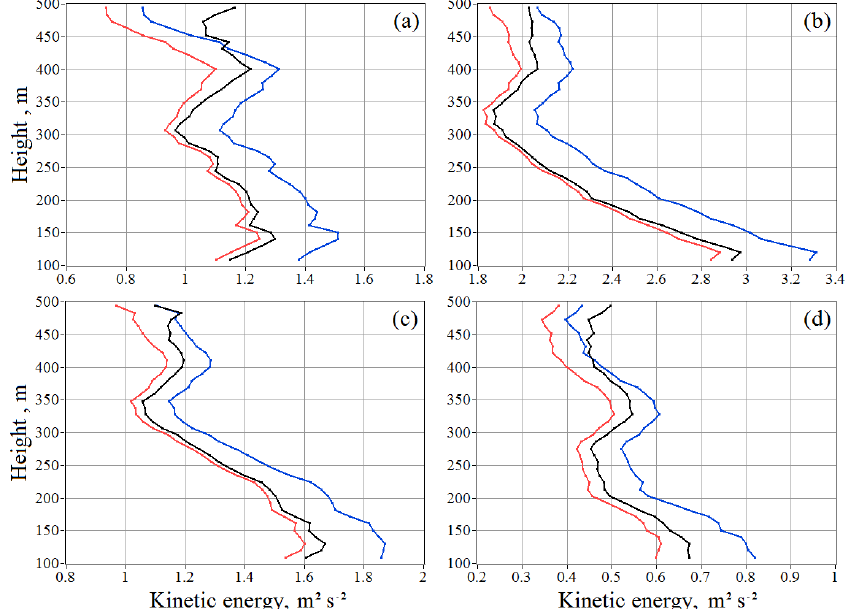
− σ 2 ] (red curves), e L